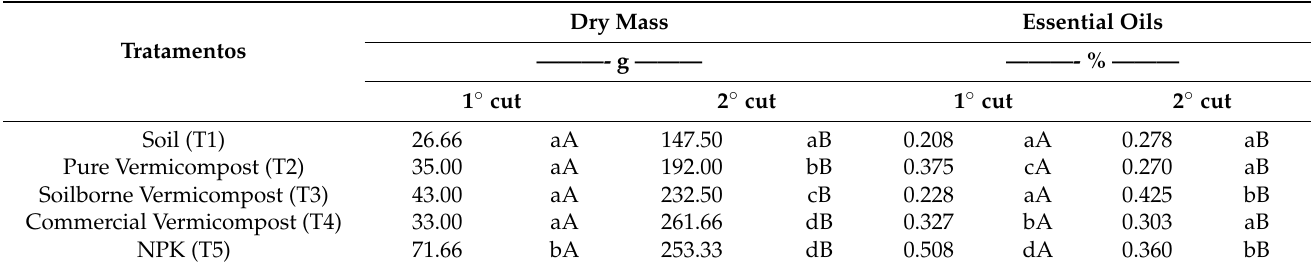
Table 8. Production of dry biomass (g/m 2 ) (FS) of the aerial part and essential oil content (%) influenced by the application of three formulations of vermicompost in comparison with the controls (soil and NPK), in two cutting